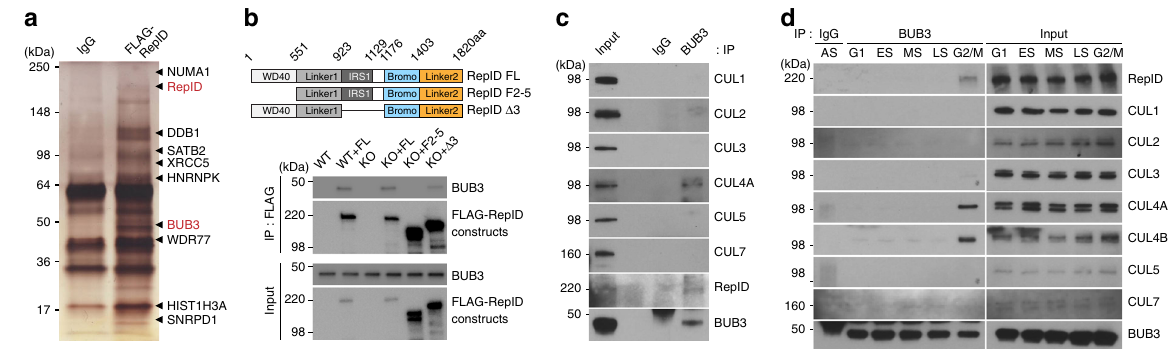
Fig. 2 RepID-CRL4 interacts with BUB3 during mitosis. a BUB3 interacts with RepID. Soluble nuclear and chromatin-bound fractions were extracted from RepID FL-stable U2OS cells and immunoprecipitated using an anti-FLAG antibody, followed by mass spectrometric analysis. b The WD40 domain of RepID is required for interaction with BUB3. Top, constructs of RepID variants used in this analysis. Bottom, nuclear and chromatin-bound fractions were extracted from U2OS cells expressing the RepID FL, F2 – 5, and Δ 3 fragments and were immunoprecipitated with FLAG antibody and analyzed by immunoblotting. c BUB3 interacts with RepID-CRL4. Asynchronized HCT116 RepID WT cells were lysed, and BUB3-bound proteins were immunoprecipitated with anti-BUB3 antibody, followed by immunoblot analysis. d BUB3 interacts with RepID-CRL4 during mitosis. K562 RepID WT cells were fractionated by elutriation, and a mixture of soluble nuclear and chromatin-bound fractions were immunoprecipitated with anti-BUB3 antibody, followed by immunoblot (Fig. 3e, lane 3). In contrast, ubiquitinated BUB3 was not detected in RepID KO cells even 3 h after release from nocodazole (Fig. 3e, lane 8). Similar results were obtained with two additional RepID- depleted cell lines (H1299, non-small cell lung cancer; DMS114,